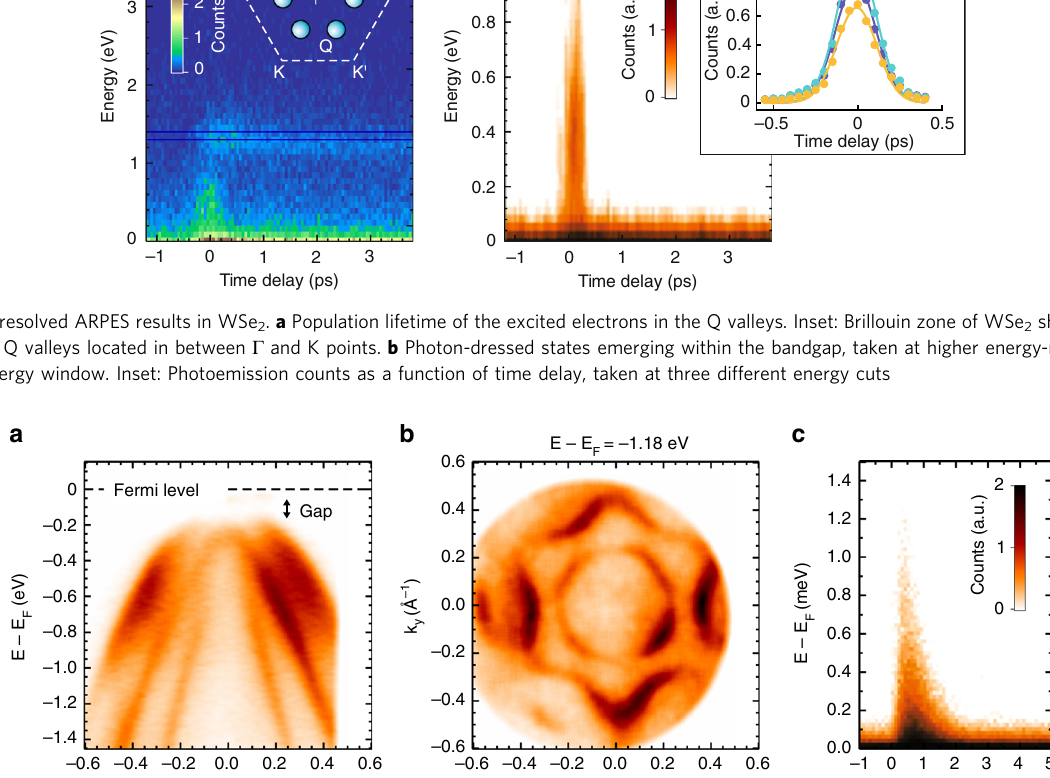
sliding stage for quick switching inside the vacuum. In this experiment, the grating is mounted such that the groove lines are parallel to the plane of incidence. This is called an OPM 42 grating con fi guration, and the resulting conical spectral disper- sion forms an arc perpendicular to the plane of incidence (Fig. 2b, c). The OPM con fi guration at grazing incidence provides better fl ux throughput (grating ef fi - ciency of about 25%) and less pulse width broadening compared to the conven- tional in-plane grating setup. The active grating is mounted on a motorized rotation stage with the rotation axis coinciding with the surface of the grating oriented along the plane of incidence. The energy linewidth of the outgoing beam can be reduced by narrowing the exit slit horizontally. The dispersions at the slit using different gratings are 2.5 nm/mm (500g/mm), 1.3nm/mm (964g/mm), 1.0nm/mm (1200g/mm). Separate from this design, various monochromator con fi gurations can be considered for future improvements in the time-resolution, energy-resolution, and throughput 62 – 64 . The re fl ectivity of XUV light is very sensitive to the incidence angle, photon energy and polarization, which can be theoretically estimated through calculations using the Fresnel equations 65,66 . Here, the incidence angle is measured relative to the surface and not to the surface normal. For example, at 45° incidence angle, 30eV photon energy and light polarization parallel to the surface, the estimated re fl ectivity of a gold-coated mirror is 22%; meanwhile, at 5° grazing incidence angle, the re fl ectivity is 85%. The incidence angle and focal length are crucial parameters that determines the overall performance of the monochromator. We fi rst de fi ne the desired spectral resolution of R = λ / Δλ = 1000 and the photon fl ux of 1× 10 10 photons/sec at the exit slit. As we use lower incidence angle and longer focal length, the mirror re fl ectivity and the dispersion increase respectively. However, the beam footprint could increase beyond the optics and result in a signi fi cant photon loss. Moreover, as the transverse footprint increases, more grating lines are illuminated and the diffraction lines are sharper. On the other hand, the diffracted optical delay between the footprint edges can contribute to the pulse width broadening. For this reason, we implement the 5° grazing incidence